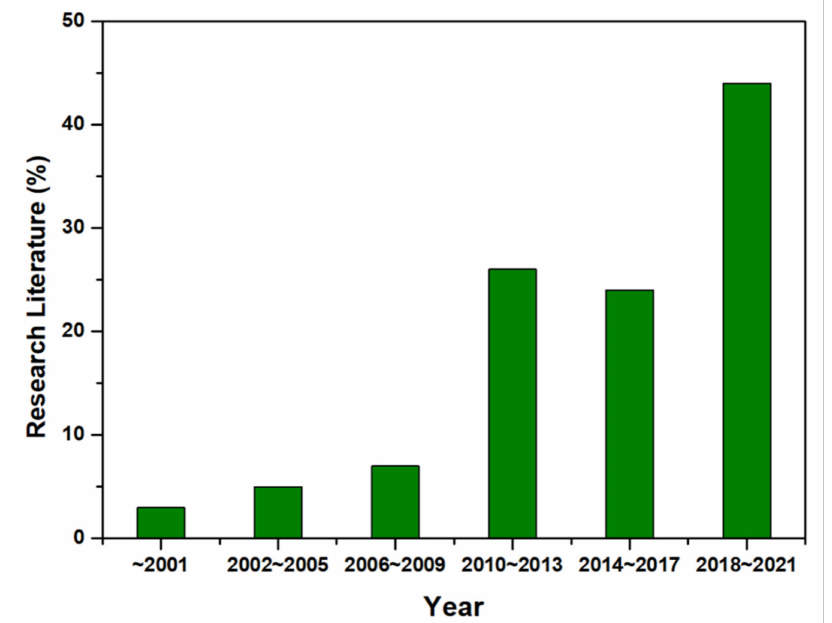
Figure 2. The distribution of research publications from 2001 to 2021 for TSV and solder